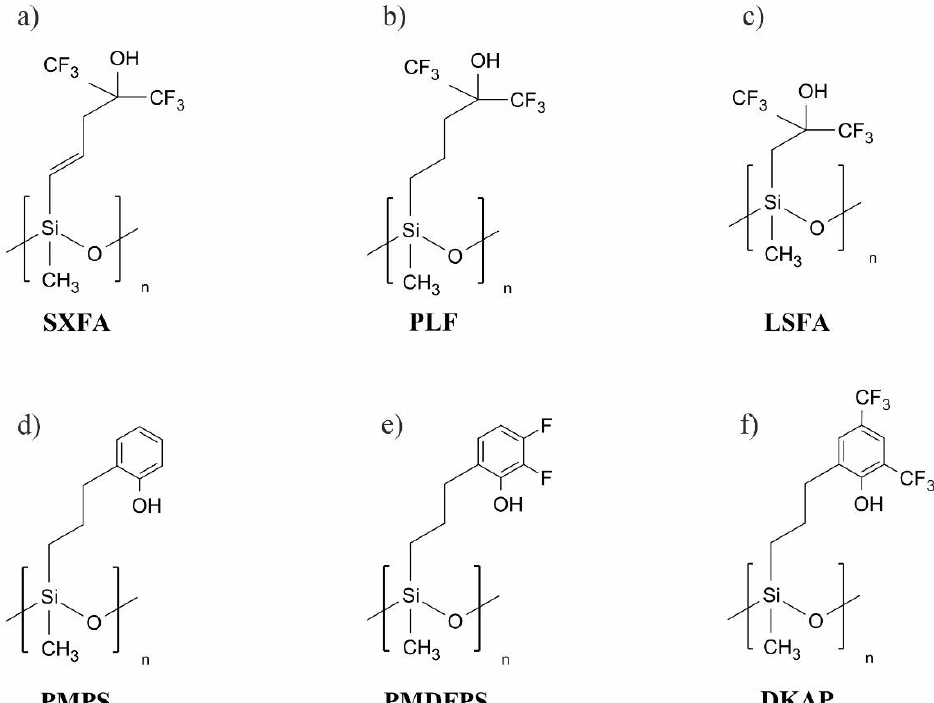
Figure 1. Selected HBA polysiloxanes used in acoustic wave sensors of nerve CWAs and their sim- ulants: a) SXFA [14]; b) PLF [12]; c) LSFA [13]; d) PMPS [17]; e) PMDFPS [18]; f) DKAP [19,20].